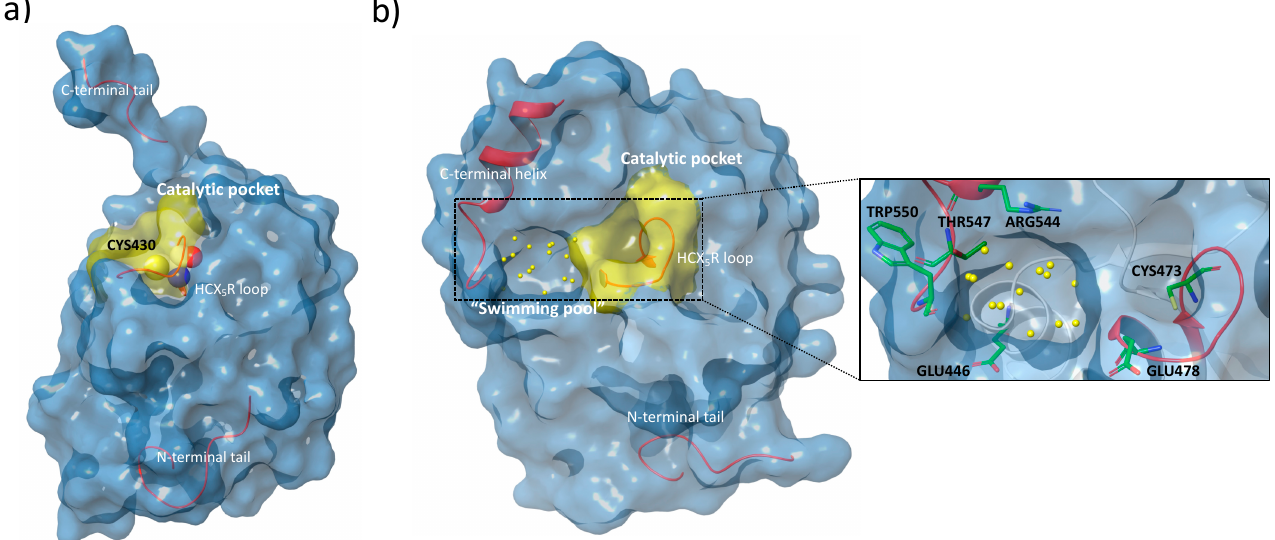
Figure 2. ( a ) Surface view of the Cdc25A crystal structure (PDB id: 1C25) [20] with the catalytic Cys430 in the HCX 5 R loop (Cdk representation) and the C/N terminal tails highlighted. ( b ) Surface view of the Cdc25B crystal structure (PDB id: 1QB0) [21] with the catalytic HCX 5 R loop, the water molecules of the “swimming pool” region (yellow dots), the C-terminal helix, and the N-terminal tail highlighted. On the right, special focus is given to several of the most important residues (thick tube representation) within the catalytic pocket and the “swimming pool” involved in the catalytic process and the interactions with ligands.